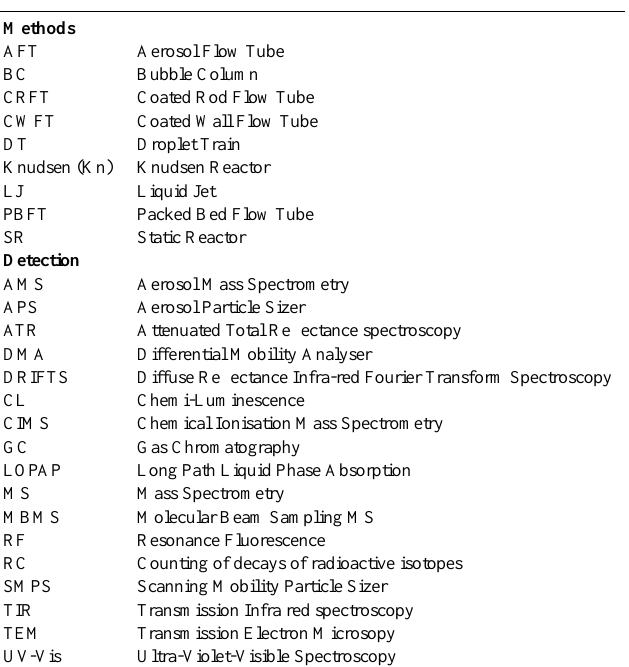
Table 2. Techniques used to study heterogeneous